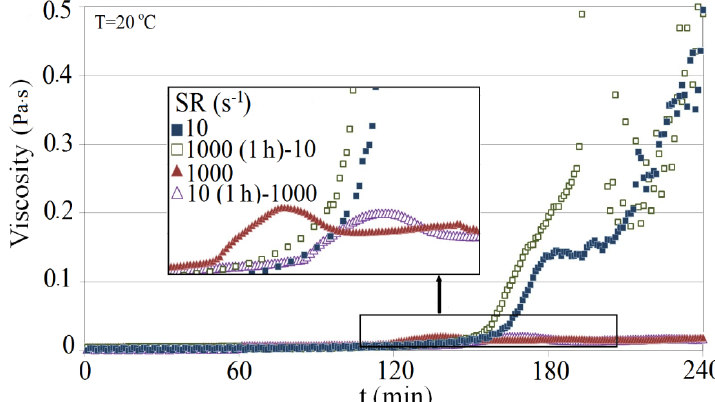
Figure 14. Viscosity profiles for 4.5 wt% Na-silicate with a pH of 10.30 for two shear rates (10 s − 1 and 1000 s − 1 ) and combined shear rates (10 s − 1 for 1 h, then 1000 s − 1 and 1000 s − 1 for 1 h, then 10 s − 1 ).